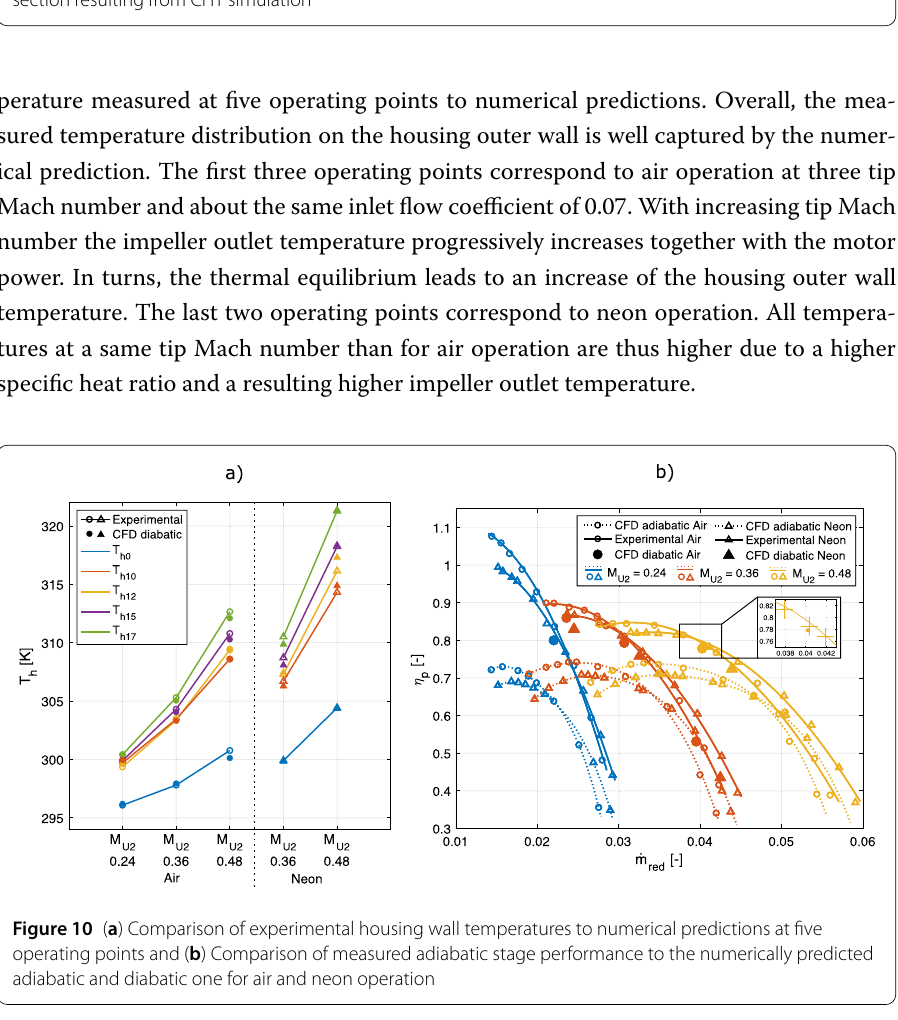
adiabatic and diabatic one for air and neon